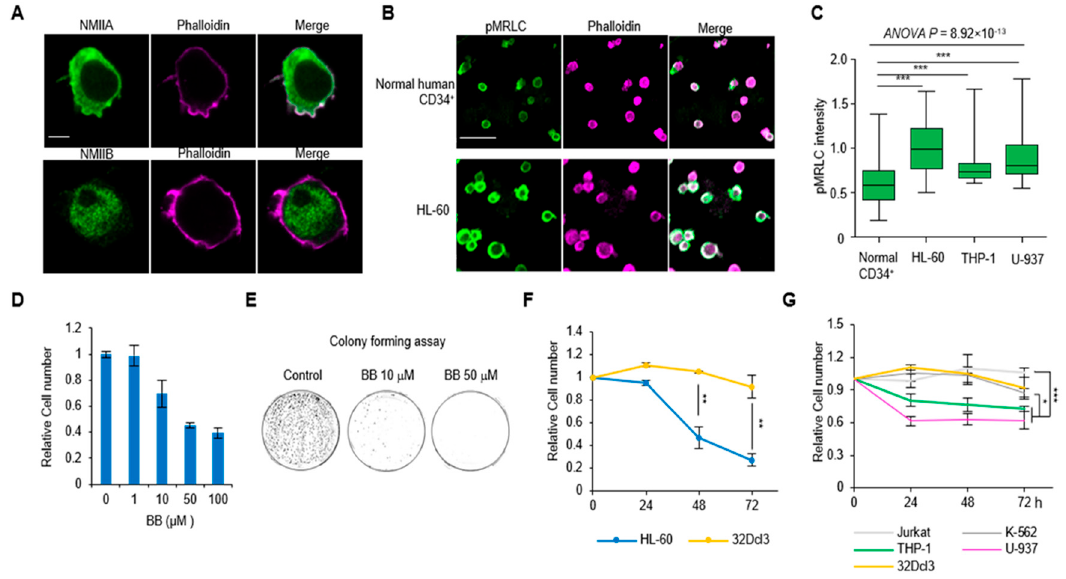
Figure 1. The relationship of actomyosin contractility and acute myeloid leukemia (AML) cell growth. ( A ) The localization of non-muscle myosin II (NMII) A or B (green) and their spatial relationship with phallodin (magenta) in AML cell line HL-60. ( B ) Immunofluorescence images of the phosphorylation level of the myosin regulatory light chain (pMRLC) expression between normal CD34 + cells and HL-60 cells. ( C ) Quantification of the expression of pMRLC in AML cell lines (THP-1 and U-937) (CD34 + : n = 67; HL-60: n = 44; THP-1: n = 39; U-937: n = 71). Data are presented as median ± min / max. ( D ) Viable HL-60 cells counted after treatment with the indicated dose of blebbistatin (BB) in 24 h ( n = 3). Data are represented as mean ± SEM. ( E ) Representative images of the colonies of HL-60 cells in methylcellulose-based medium with blebbistatin treatment. ( F ) The results of blebbistatin (50 µ M) induced cell number changes between normal 32Dcl3 myeloid cells and HL-60 cells in a time-dependent manner ( n = 6). Data are represented as mean ± SEM. ( G ) Quantification of the cell number changes of various leukemic cell lines upon 50 µ M blebbistatin treatment ( n = 6). Data are represented as mean ± SEM. Scale bars: 5 µ m (A), 50 µ m (B). * p < 0.05, ** p < 0.01, *** p < 0.001.